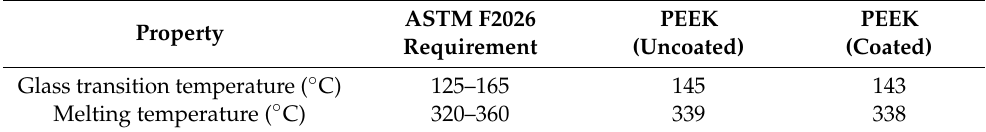
Figure 11. Dynamic difference calorimetry graphs of PEEK: ( a ) uncoated PEEK; ( b ) coated PEEK. Table 3. Results of the dynamic difference calorimetry compared to the requirements of ASTM